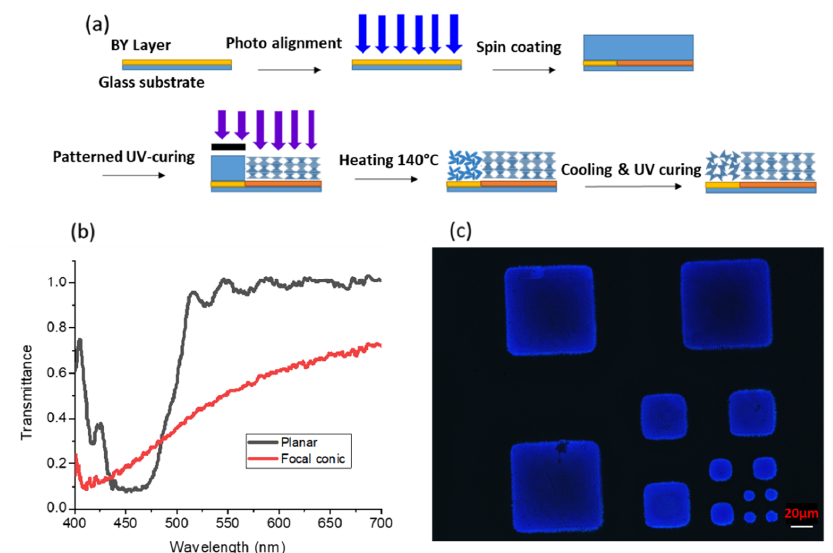
Figure 1. ( a ) Fabrication process of a patterned cholesteric liquid crystal (CLC) film. ( b ) Measured transmission spectra of planar and focal-conic texture CLC on a patterned CLC film. ( c ) Microscope image showing a patterned CLC film with 10 μm, 20 μm, 40 μm, and 80 μm feature sizes.